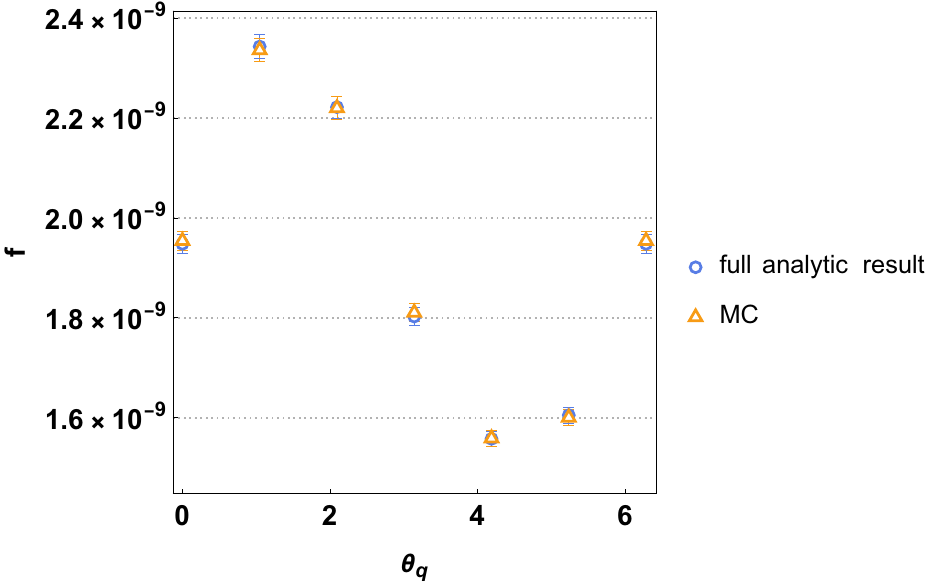
Figure 1: Gluon Green’s function dependence on θ q for fixed | ~k a | , | ~k b | , | ~q | , θ a , θ b and Y .